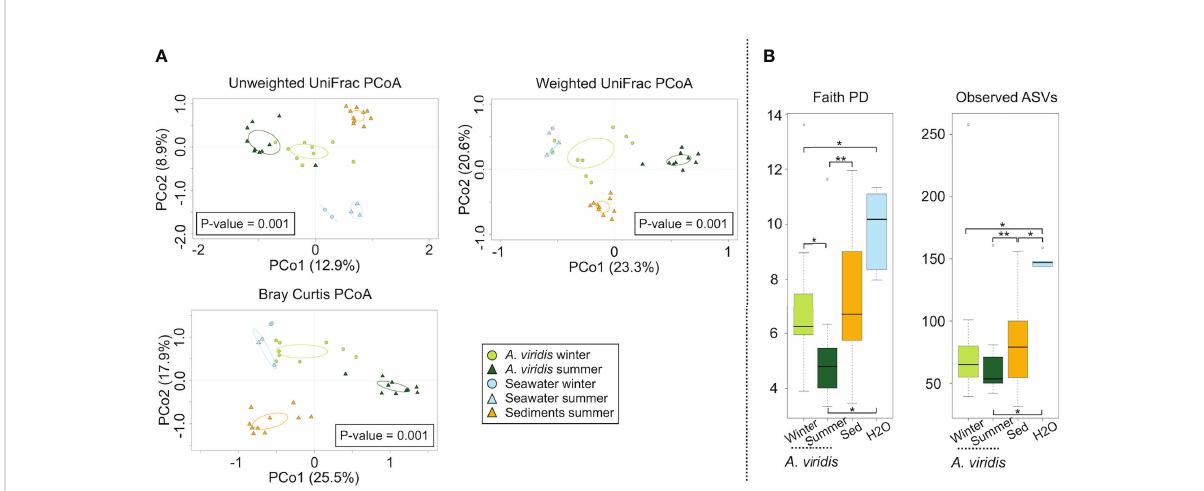
FIGURE 2 Overall microbiota compositional structure of Anemonia viridis and the surrounding environment in the Riccione site. (A) Principal coordinate analysis (PCoA) based on the unweighted UniFrac distance, weighted UniFrac distance, and Bray – Curtis distance between the microbial pro fi les of A. viridis and the environmental samples in the Riccione site shows a strong separation between the groups (permutation test with pseudo-F ratio, p-value = 0.001). Concordance between A. viridis microbiota variations in different PCoA models was highlighted using a procrustean randomized test ( “ protest ” ) (unweighted vs. weighted UniFrac distance and unweighted vs. Bray – Curtis distance resulted in p-value = 0.0001 for both tests, and correlation in a symmetric rotation = 0.8873 and 0.8851, respectively). The fi rst and second principal components (PCo1 and PCo2) are plotted, and the percentage of variance in the data set explained by each axis is reported. Ellipses include a 95% con fi dence area based on the standard error of the weighted average of the sample coordinates. A. viridis samples are represented in green ( “ darkolivegreen1 ” circles for winter, “ darkgreen ” triangles for summer), seawater samples are represented in light blue ( “ lightskyblue1 ” circles for winter, “ lightskyblue1 ” triangles for summer), and sediment samples are represented in “ darkgoldenrod1 ” triangles. (B) Box-and-whiskers distribution of the alpha diversity metrics Faith ’ s phylogenetic diversity (PD) and number of observed ASVs. Signi fi cant p-values (Wilcoxon rank-sum test controlled for multiple testing using FDR, p-value ≤ 0.05) are reported in the fi gure with the following symbols: p-value ≤ 0.05 *; p-value ≤ 0.01 **. The color code is the same as in panel